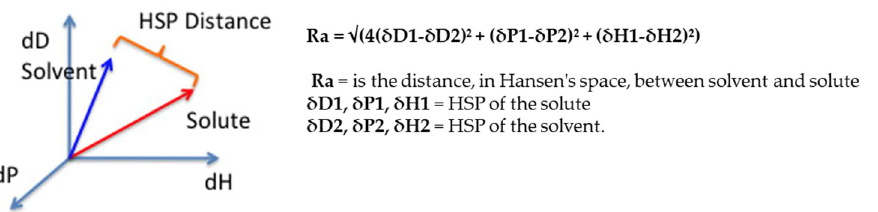
Figure 3. Equation and graphical representation of Ra (HSP distance) between a solute and a solvent in Hansen’s space. Reprinted and adapted with permissions from [9,10].